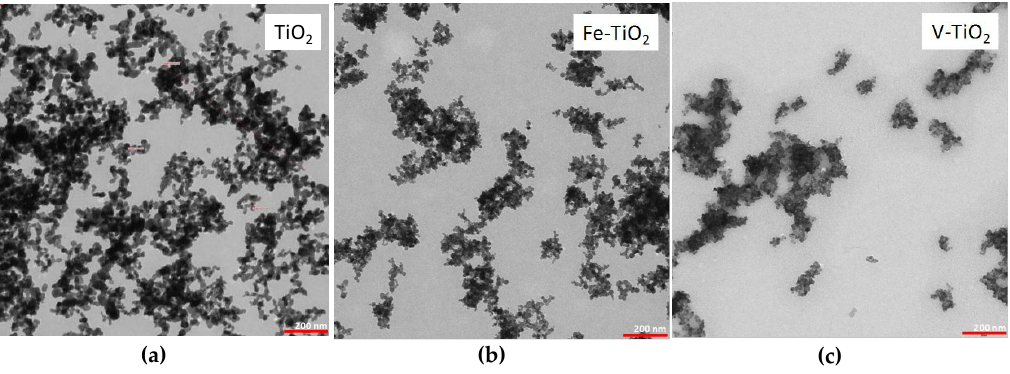
Figure 1. TEM micrographs of the nano-structured additives (×16,000): ( a ) TiO 2 ; ( b ) Fe-TiO 2 ; ( c ) V-TiO 2 .